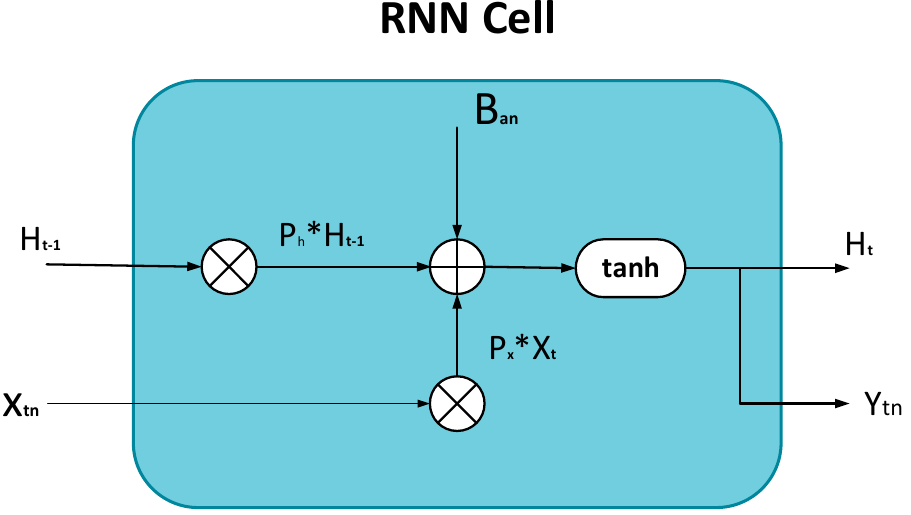
Figure 6. RNN internal structure.